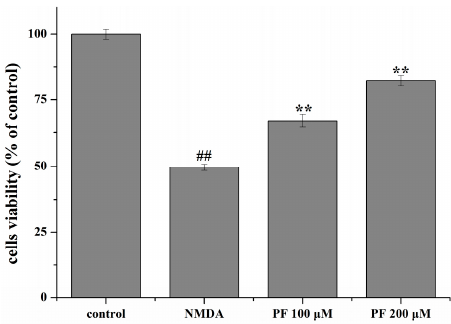
Figure 3. Effects of PF on N -methyl- D -aspartic acid (NMDA)-induced excitotoxicity in neurons as assessed by 3-(4,5-dimethyl-2-thiazolyl)-2,5-diphenyl-2-H-tetrazolium bromide (MTT). NMDA stimulation decreased cell viability in neurons. PF promoted cell survival. ## p < 0.01 vs. control; ** p < 0.01 vs. NMDA. Data are mean ± SD ( n = 8).